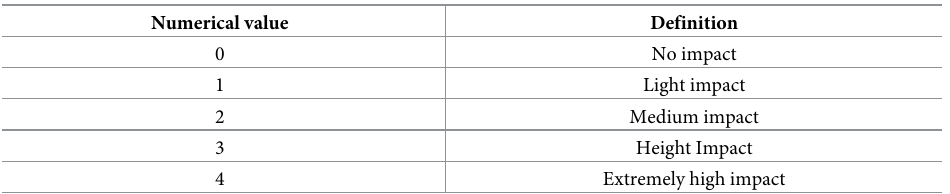
Table 4. Expert semantic variables.